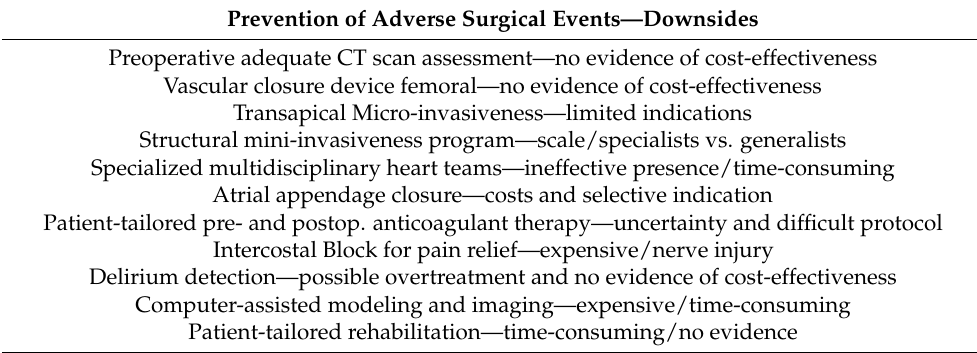
Table 4. Summary of possible measures to prevent surgical